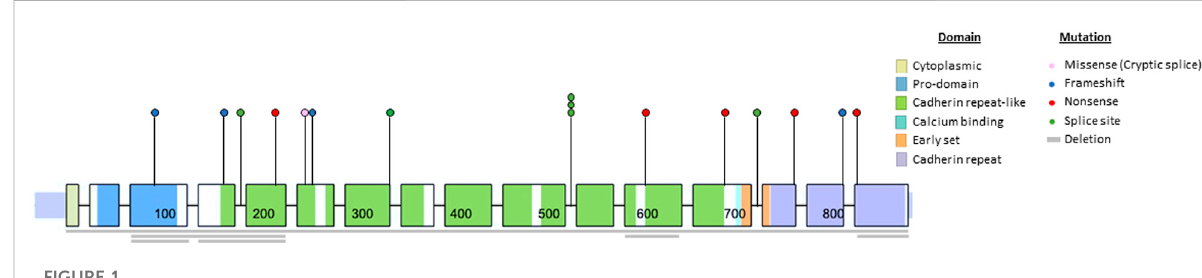
FIGURE 1 Map of variants in CDH1 for patients reporting family history of CLP.